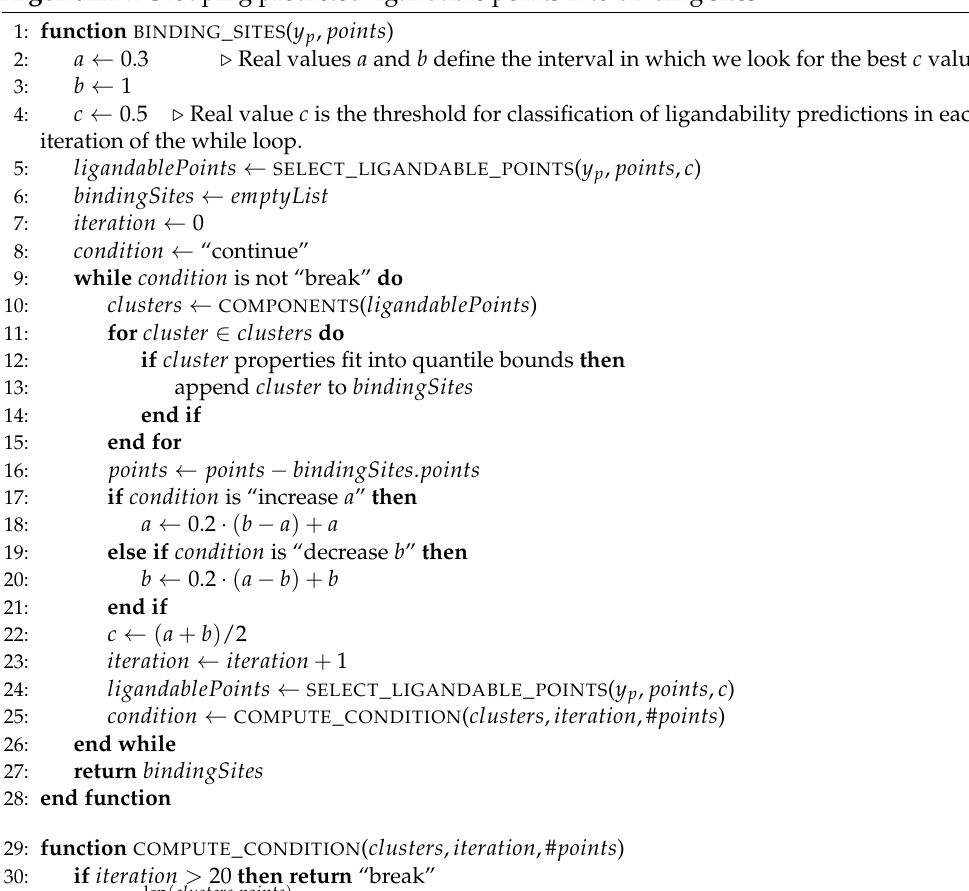
Algorithm 1 Grouping predicted ligandable points into binding